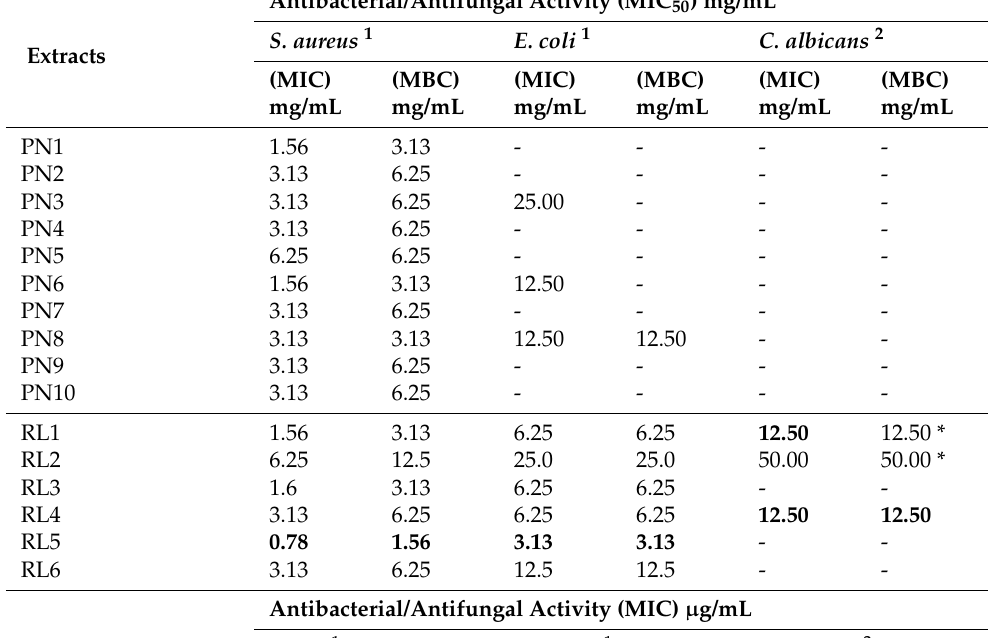
Table 5. Minimum inhibitory concentration (MIC) and minimum bactericidal concentration (MBC) values of PN and RL wine